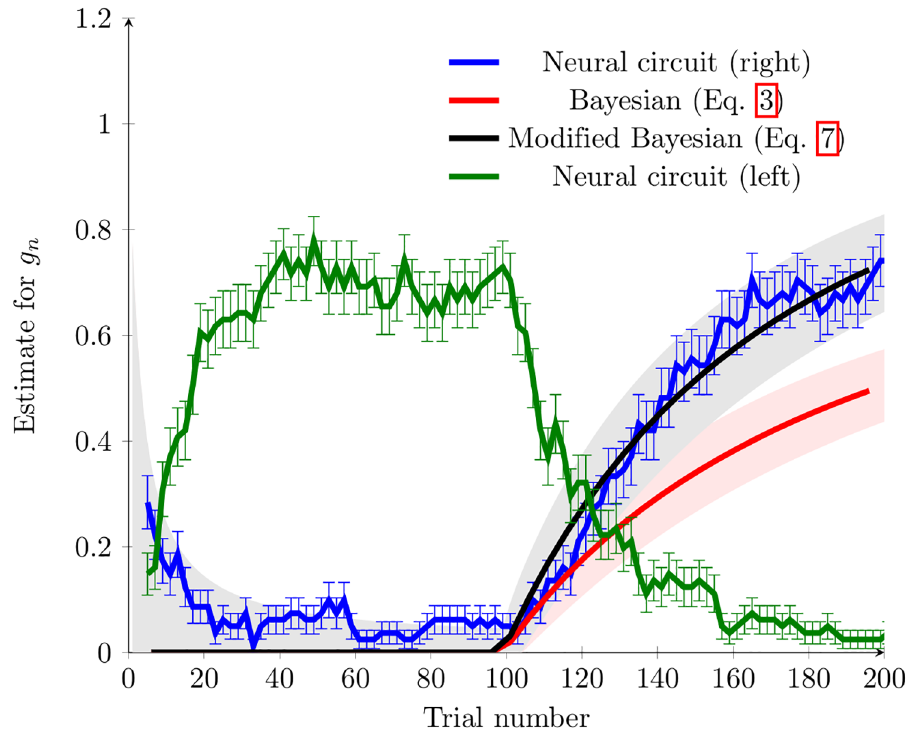
Fig 6. A comparison of estimation methods in the switching task in the T-maze. After 100 trainingtrials, the association betweencues and goals was switched. We note that the neuralcircuit adapts to this change, with rapid adaptationof the response rates to be more consistent with the new relationship betweencue and goal. The neuralcircuit is shown by the blue curve, the simple Bayesianmethod (Eq 3) shown by the red curve, and the modifiedBayesianmethod (Eq 7) shown by the black curve. The green curve shows the proportionof trials in which the propagatingwave pattern travelleddown the left arm of the T-maze, rather than the right arm.Alternatively, it follows from a simple symmetry argument that the green curve shows the proportionof trials in which the propagatingwave pattern travelleddown the right arm of the T-maze, but with the order trainingtrials reversed. The fact that the green and blue curves are separated at trial 200 indicates that the neuralcircuit model is sensitive to the order of trials, as in both cases, 100 L and 100 R trials have occurred. For the neuralcircuit, error bars show the SEM, and for the Bayesianmethods (Eqs 3 and 7) shadingshows the 95% confidenceinterval. We note the responses from the neural circuit are similar to that given by Eq 7, and the estimate from Eq 3 is